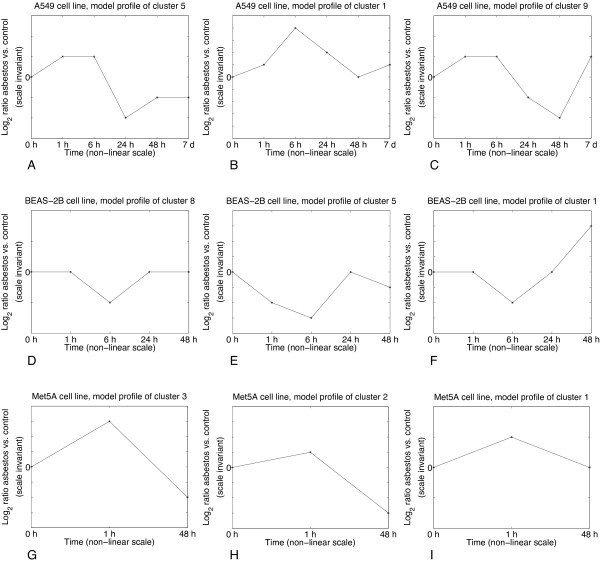
Profiles of the most significant clusters in A549 (A-C), Beas-2B (D-F) and MeT5A (G-I) cells. The X-axis shows the time points from 0 h-48 h (or in the case of A549, 7 days) and the Y-axis the expression ratio profile that is representative of all probe sets in the cluster. Due to the correlation-based distance measure used in the clustering method [48], the scale of the Y-axis is not relevant.